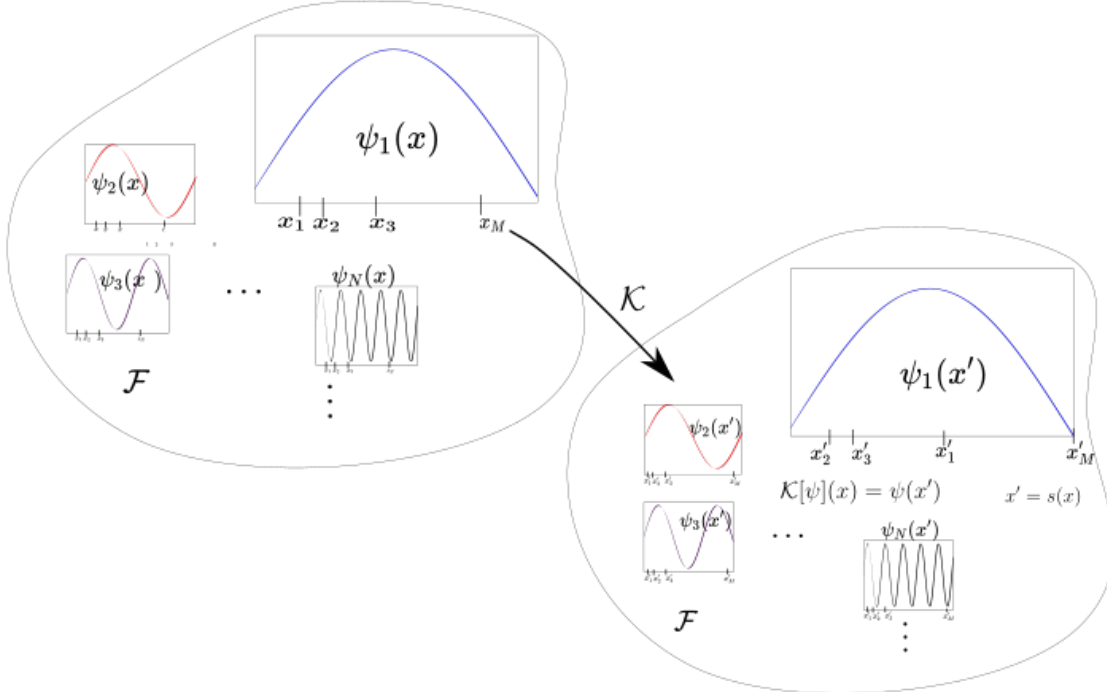
Figure 1. This figure shows the behavior of the Koopman operator K in observable space F associated with a dynamical system S . The Koopman operator evaluates the observable ψ at downstream or future x (cid:48) = x n + 1 = s ( x n )